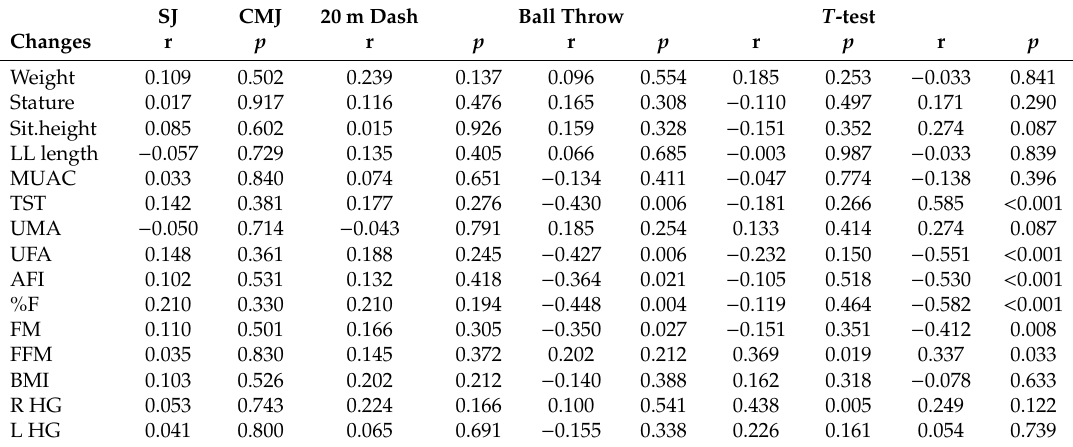
Table 2. Correlations between motor tests (second repetition) and anthropometric changes.